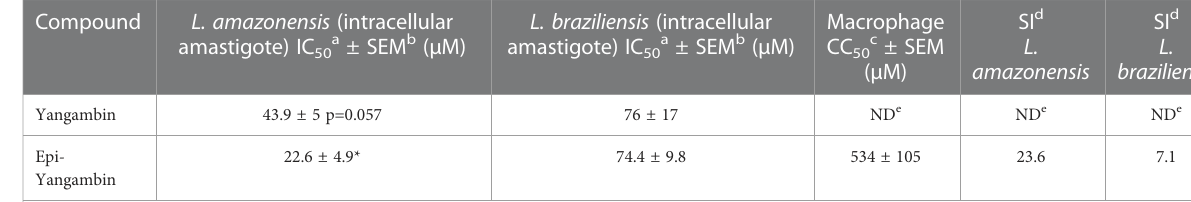
TABLE 1 IC 50 , CC 50 and Selective Index (SI) values of BMDM infected or not with Leishmania amazonensis or Leishmania braziliensis and treated for 48 h with yangambin or epi-yangambin.